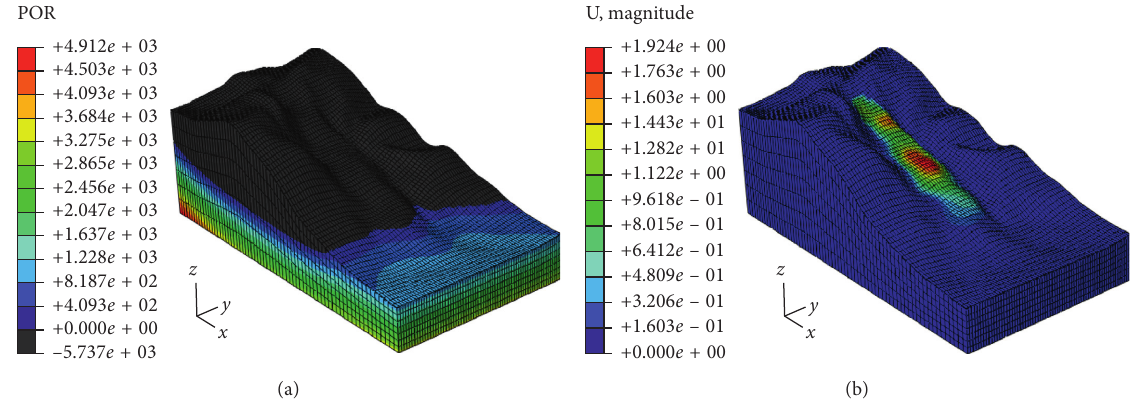
Figure 9: Deformation distribution diagram under condition 2. (a) Pore pressure distribution. (b) Displacement distribution. S, max. principal